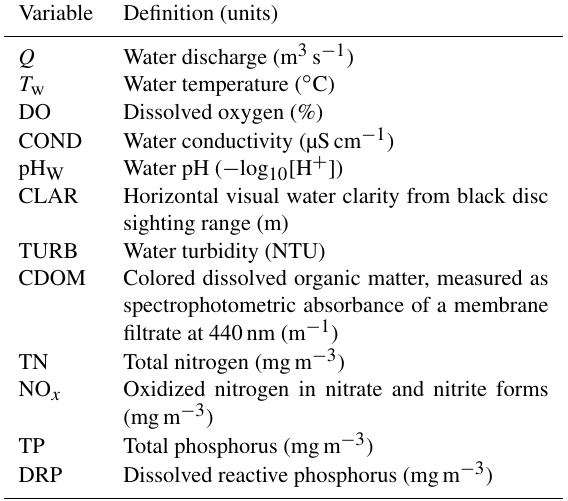
Table 1. Water quality variables measured by the National River Water Quality Network (NRWQN) obtained from monthly grab samples from 1989 to 2014 for 77 catchments. Details on analyt- ical methods can be found in Davies-Colley et al.